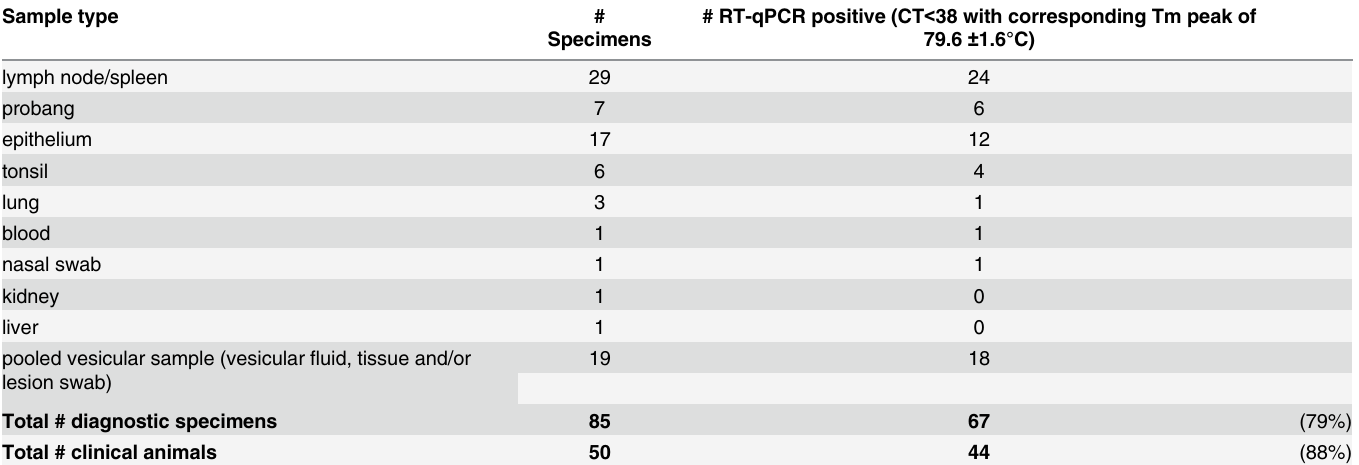
Table 2. SV-A in swine vesicular diagnostic tissues.